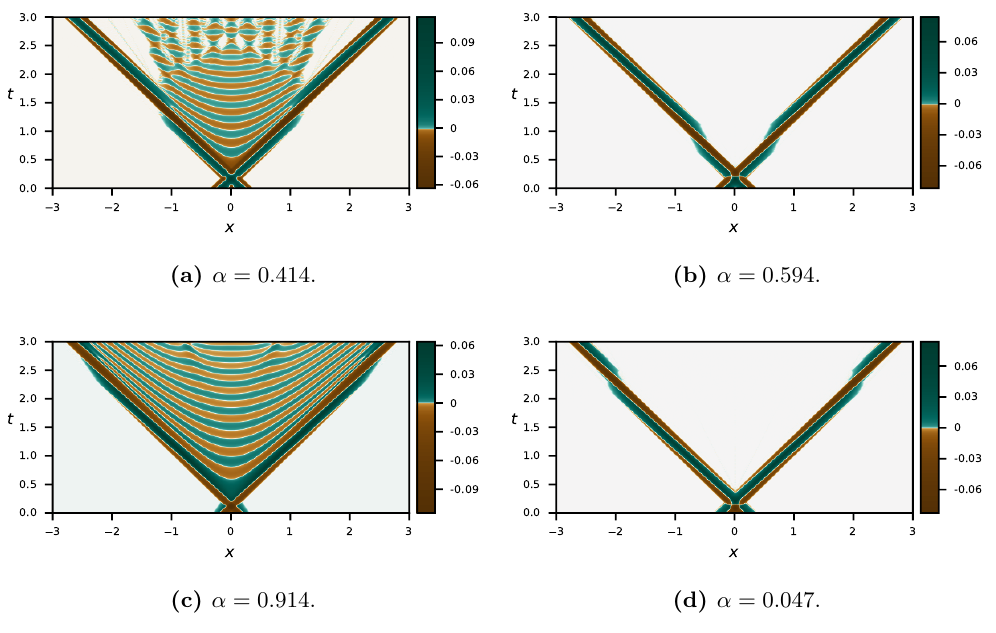
Figure 28 . The scattering processes for the initial symmetric con(cid:12)guration containing oscillons with speed V = 0 : 93, velocity of the border v = 0 : 7 for di(cid:11)erent phases (cid:11) .